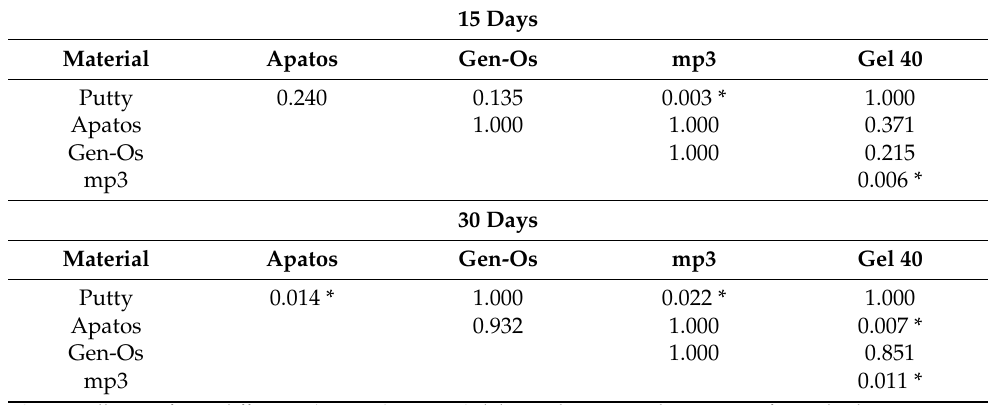
Table 3. Group comparison regarding particles percentage at both evaluated